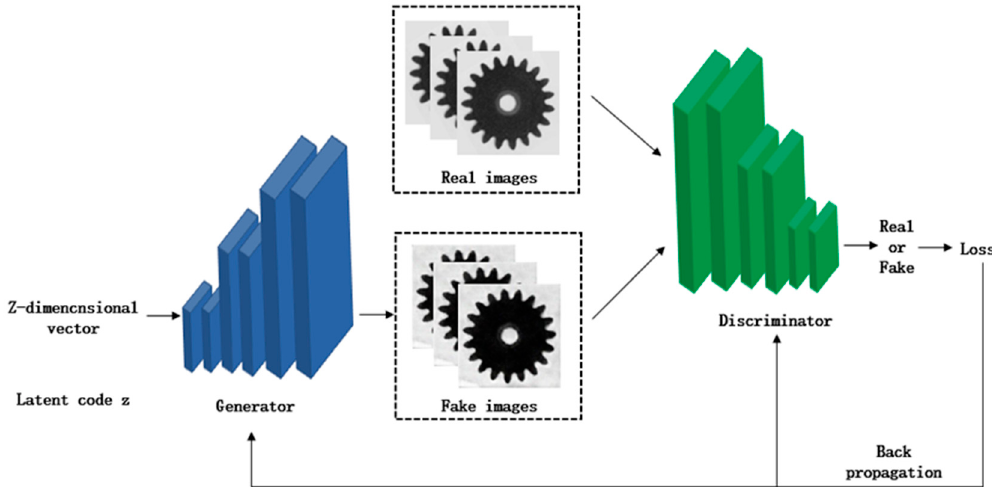
Figure 1. DCGAN general framework.